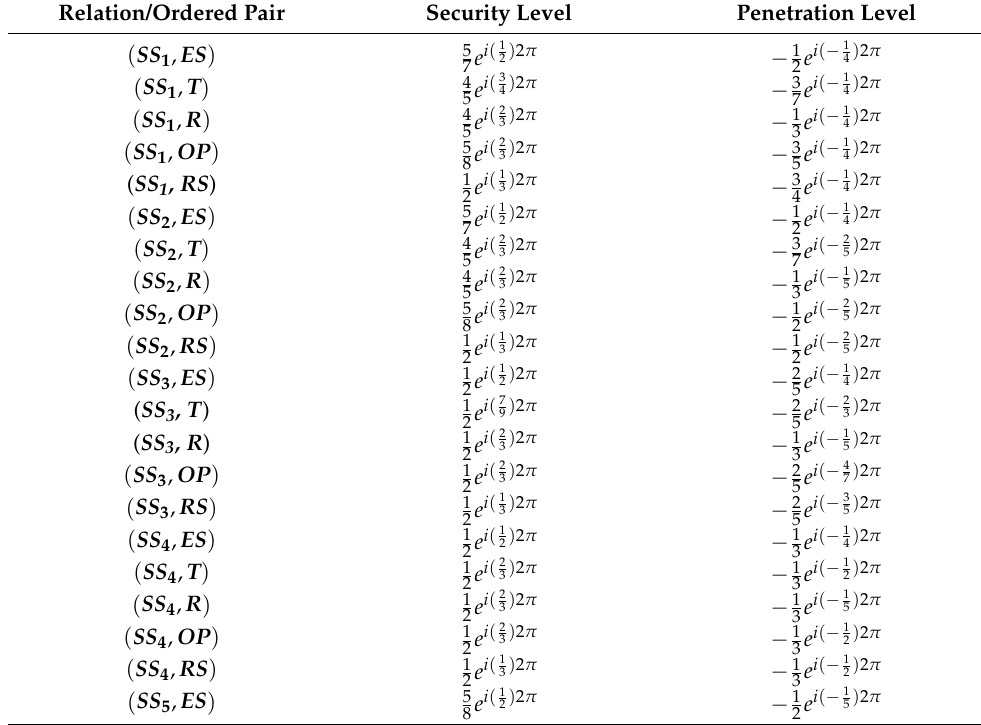
Table 4. Cartesian product between the sets of securities and attacks: S × A